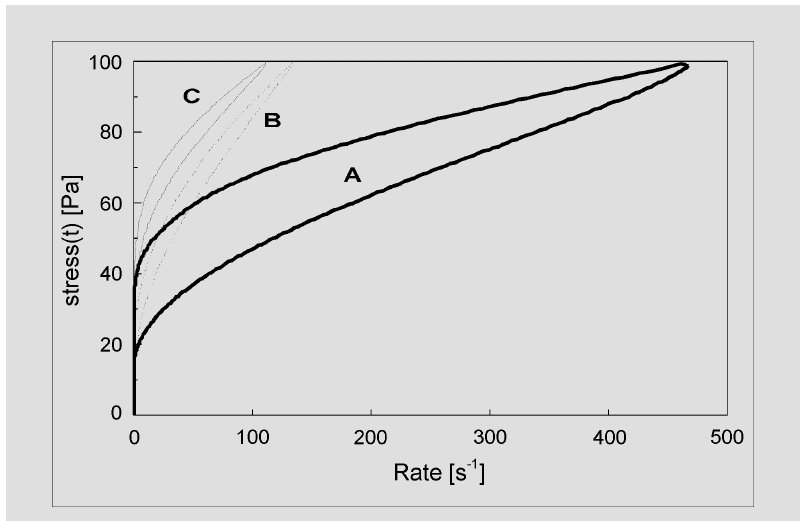
37°C.Figure 10: Thixotropic loop of shear stress versus shear